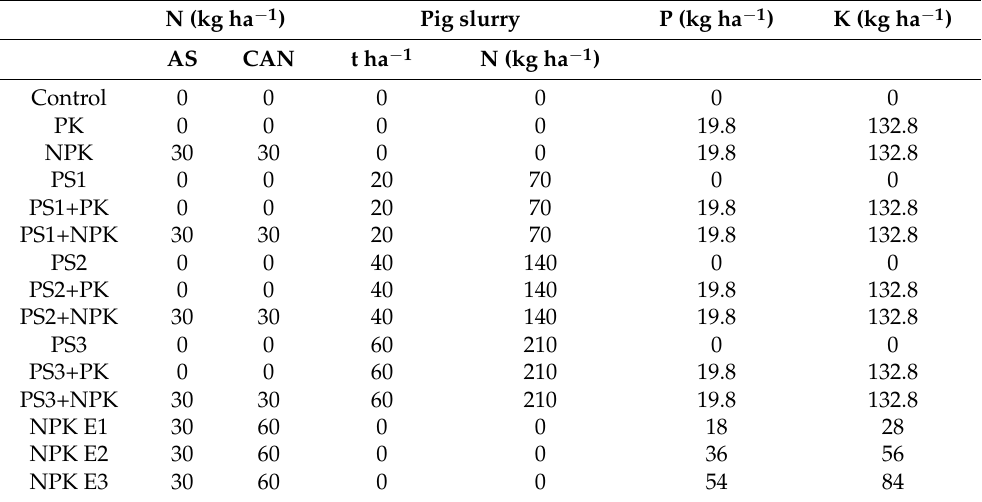
Table 3. Forms and doses of mineral fertilizers and pig slurry (PS) according to the fertilizer treatments applied to FP in